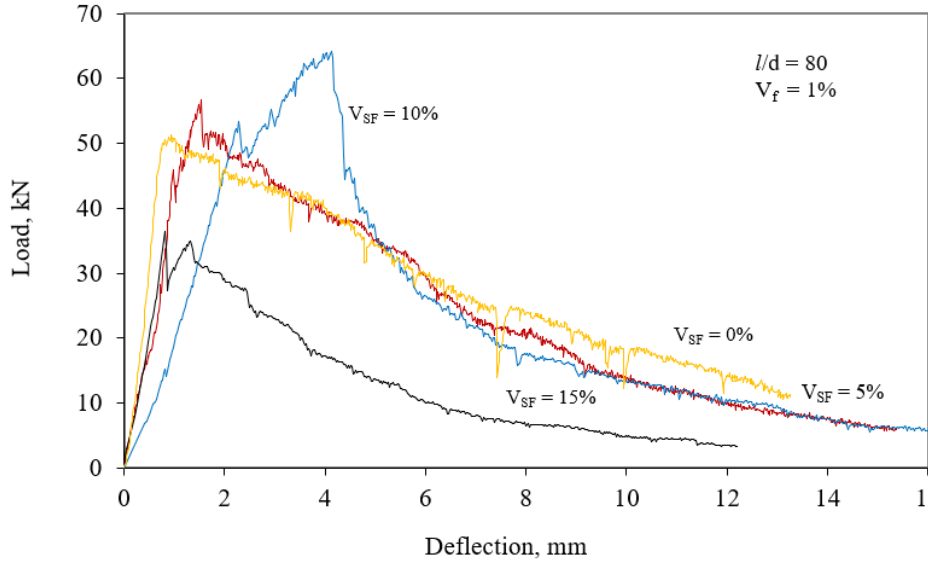
Figure 5. Load–deflection graphs of SFRCs for V f = 1% and aspect ratio of 80. Figure 5. Load – deflection graphs of SFRCs for V f = 1% and aspect ratio of 80. Table 2. Test result of mechanical properties of This parameter measures the relative increase in ductility of concrete with fibers to the control. In this study, control concrete was taken as the concrete including neither silica fume nor steel fiber. Connections among splitting tensile strength and SF content at various steel fiber contents for aspect ratios of 65 and 80 are given in Figures 6 and 7 (with error bars), respectively. Similarly, changes in toughness, depending on both silica fume content and steel fiber content, for aspect rates of 65 and 80 are given in Figures 2 and 3, respectively.